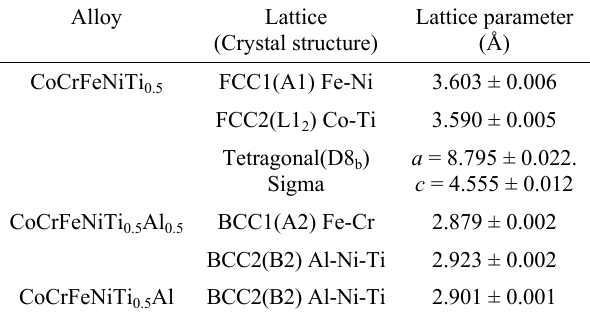
Fig. 2 XRD patterns of the as-solidified CoCrFeNiTi 0.5 Al x alloys. Phases and lattice constants of the as-solidified CoCrFeNiTi 0.5 Al x alloys as detected by XRD analysis.